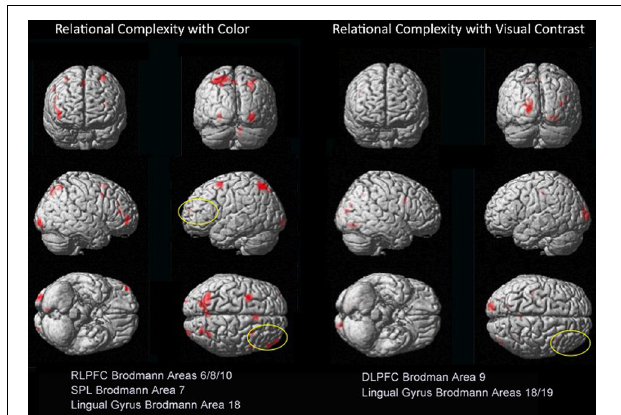
FIGURE 4 | Dissociations in prefrontal and visual-parietal regions for Color 2 > 1 and BWVC 2 > 1 relational complexity contrast results based on an RT-convolved HRF (FDR corrected, p < 0 . 05). BOLD regions consist of at least 7 voxels (threshold Z > 3 . 09).